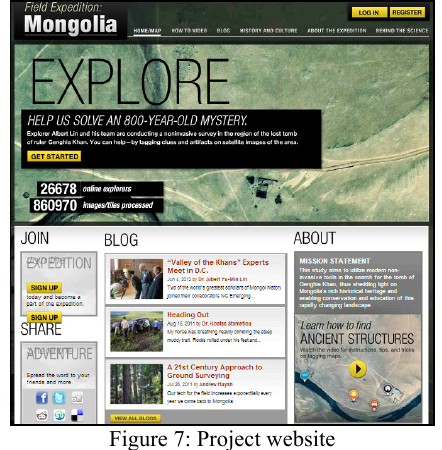
Figure 3: Cyclone Center